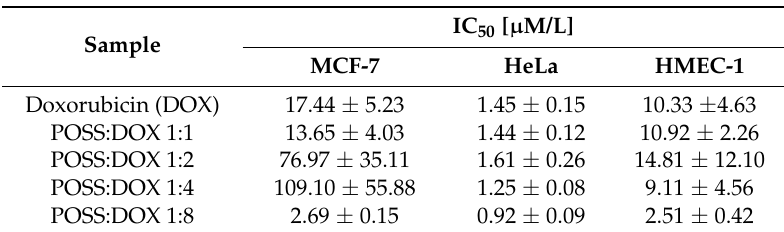
Table 1. Comparison of IC 50 values for free doxorubicin and doxorubicin co-delivered with polyhedral oligomeric silsesquioxane in three different cell lines.